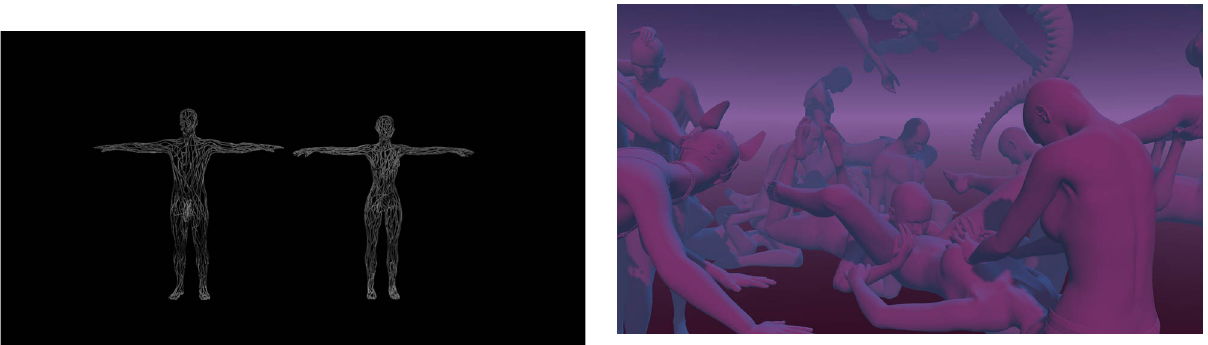
Figure 6: Two cis gender virtual avatars.